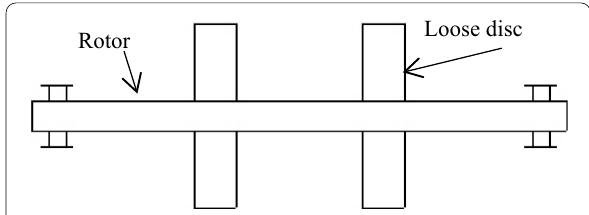
Figure 2 The model of the rotor system with loose